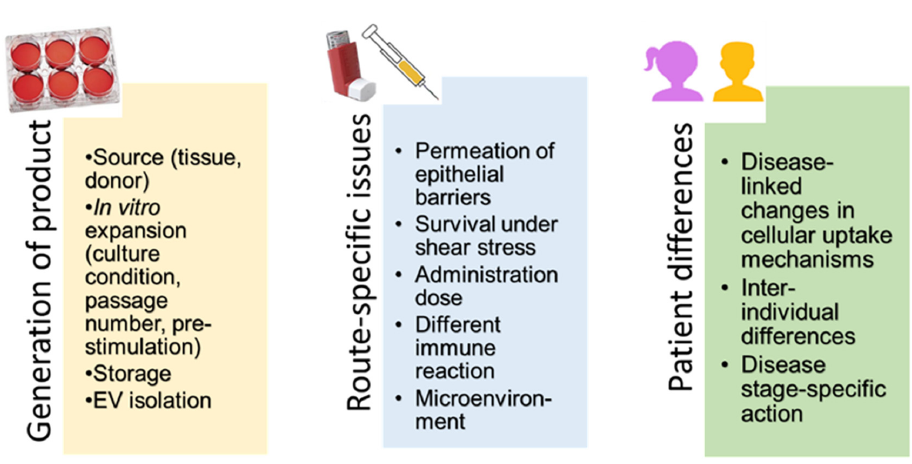
Figure 4. Overview of important sources for variability between study